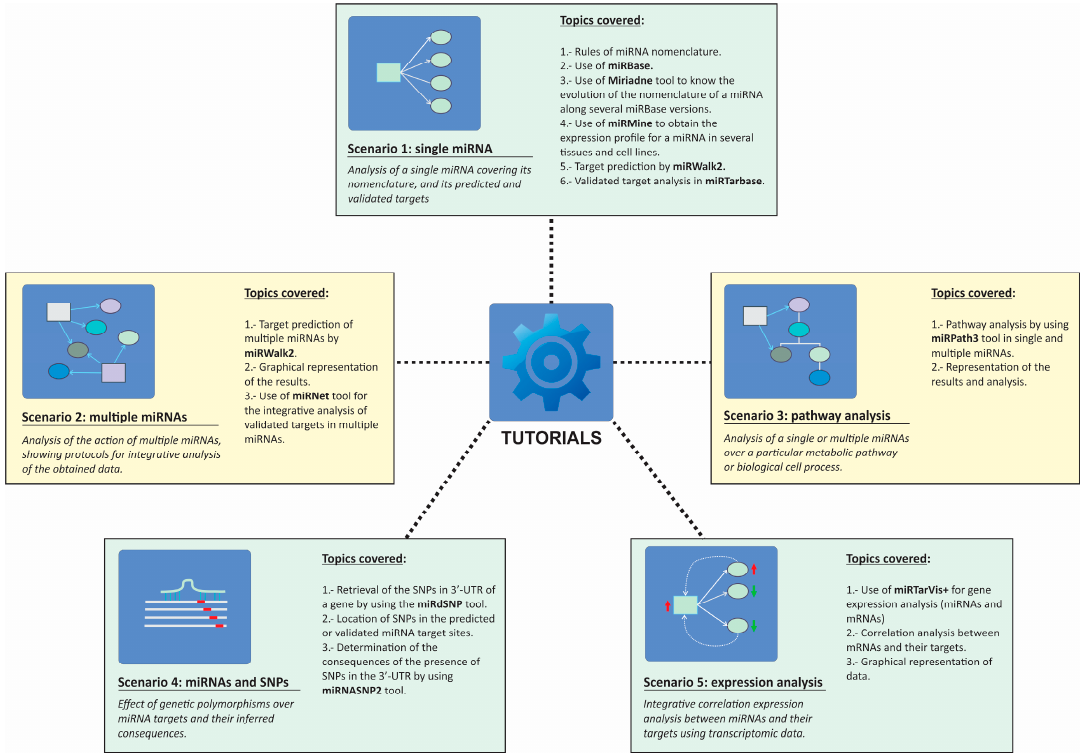
Figure 2. Structure of the tutorials section of miRNAtools3 showing all the proposed working scenarios and the topics and computer applications covered by each of